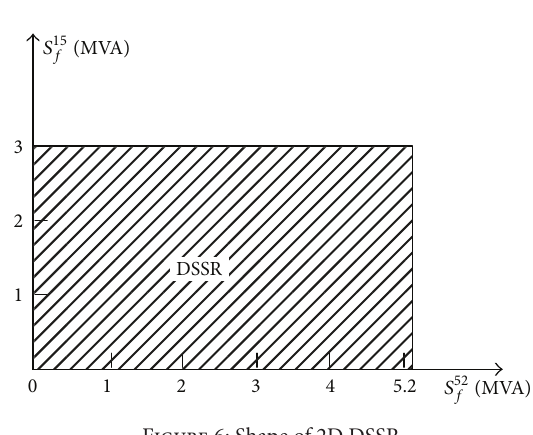
Figure 6: Shape of 2D